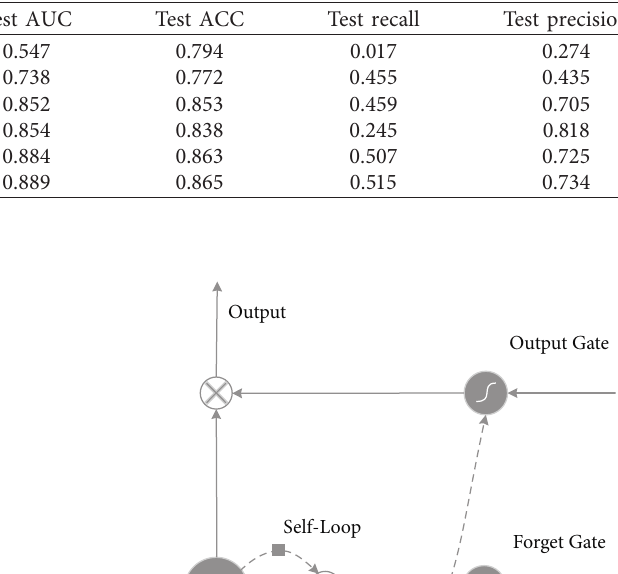
Table 5: Model evaluation indicators of machine learning